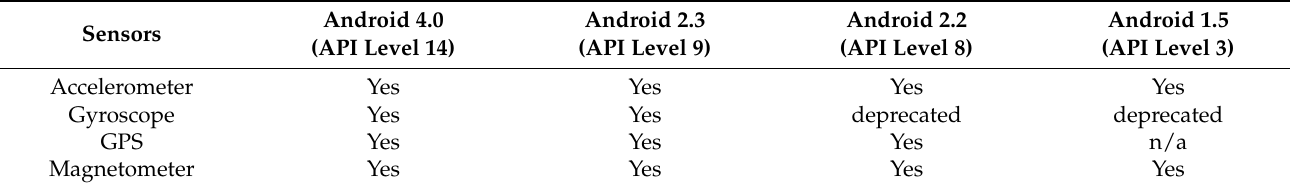
Table 1. Android Sensors API version support for sensors.